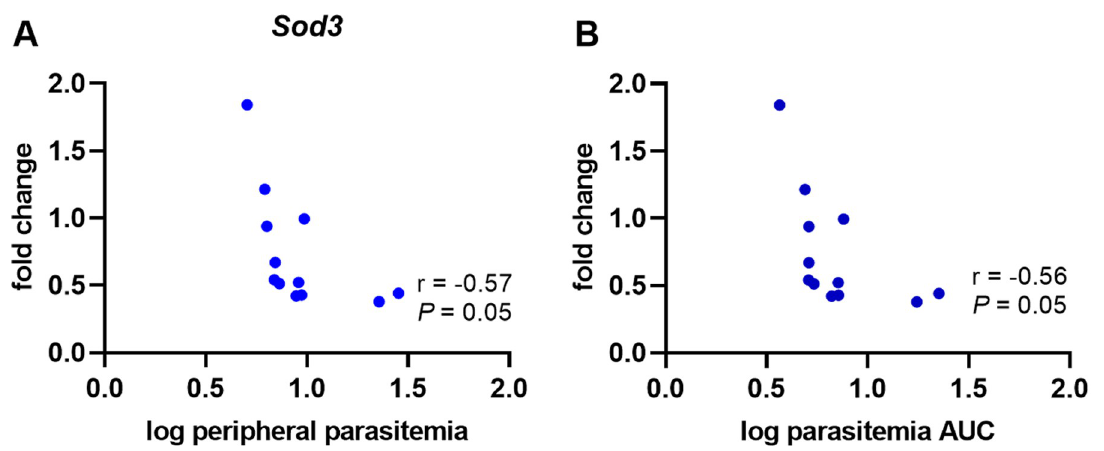
Fig 9. Placental Sod3 gene expression negatively correlates with peripheral parasitemia at sacrifice on E16.5 in mice infected on E8.5. Mouse Sod3 mRNA transcript abundance measured in placentae collected one day before expected preterm birth (E16.5) relative to (A) peripheral parasitemia at the time of sacrifice and (B) peripheral parasitemia